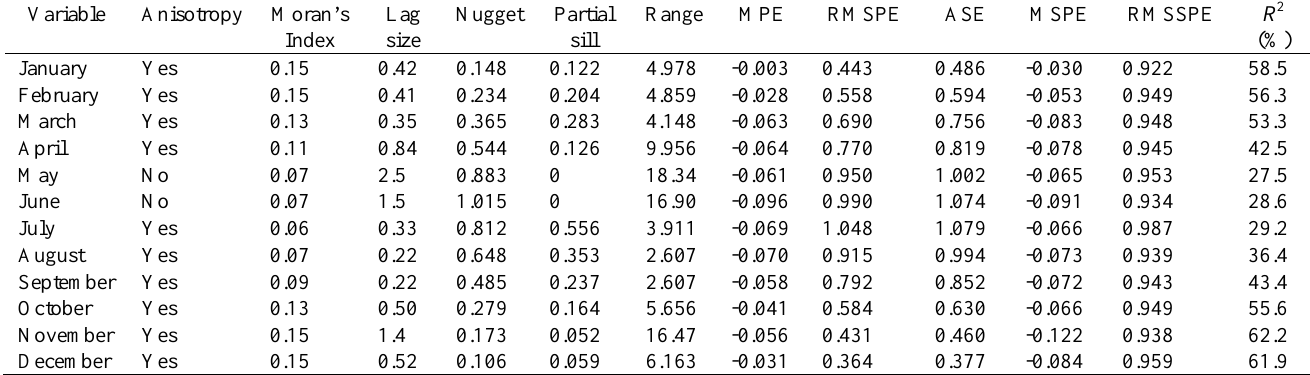
Table 4. Spherical semi-variogram models of universal kriging to derive surface maps of monthly mean daily incident photosynthetically active radiation (PAR, MJ m -2 day -1 ), and their spatial one- leave-out cross-validation